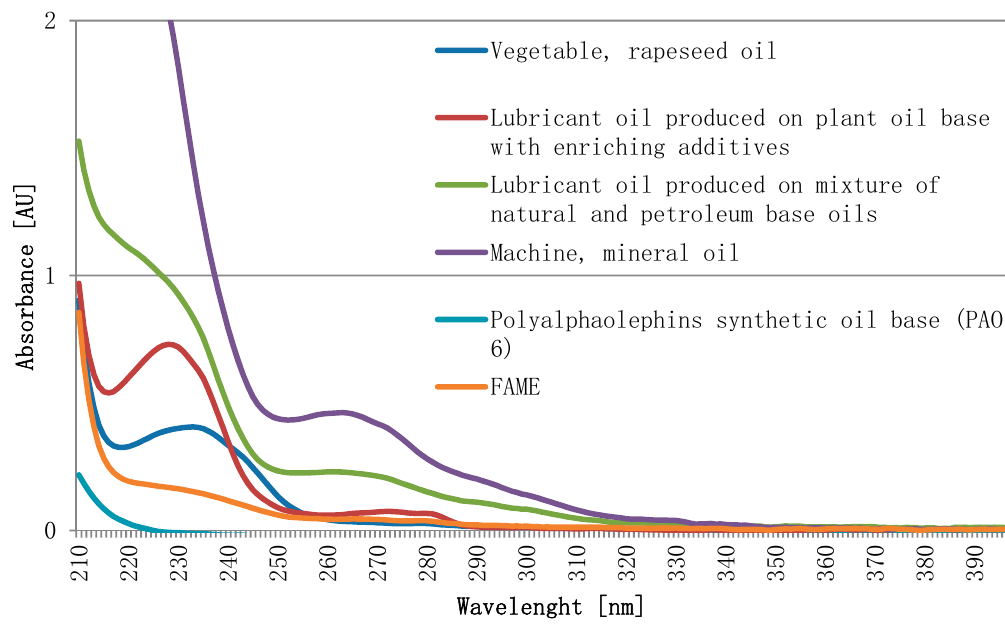
Figure 4. Compilation of UV-Vis spectra of oil samples (concentration of samples 0.25 mg oil / mL